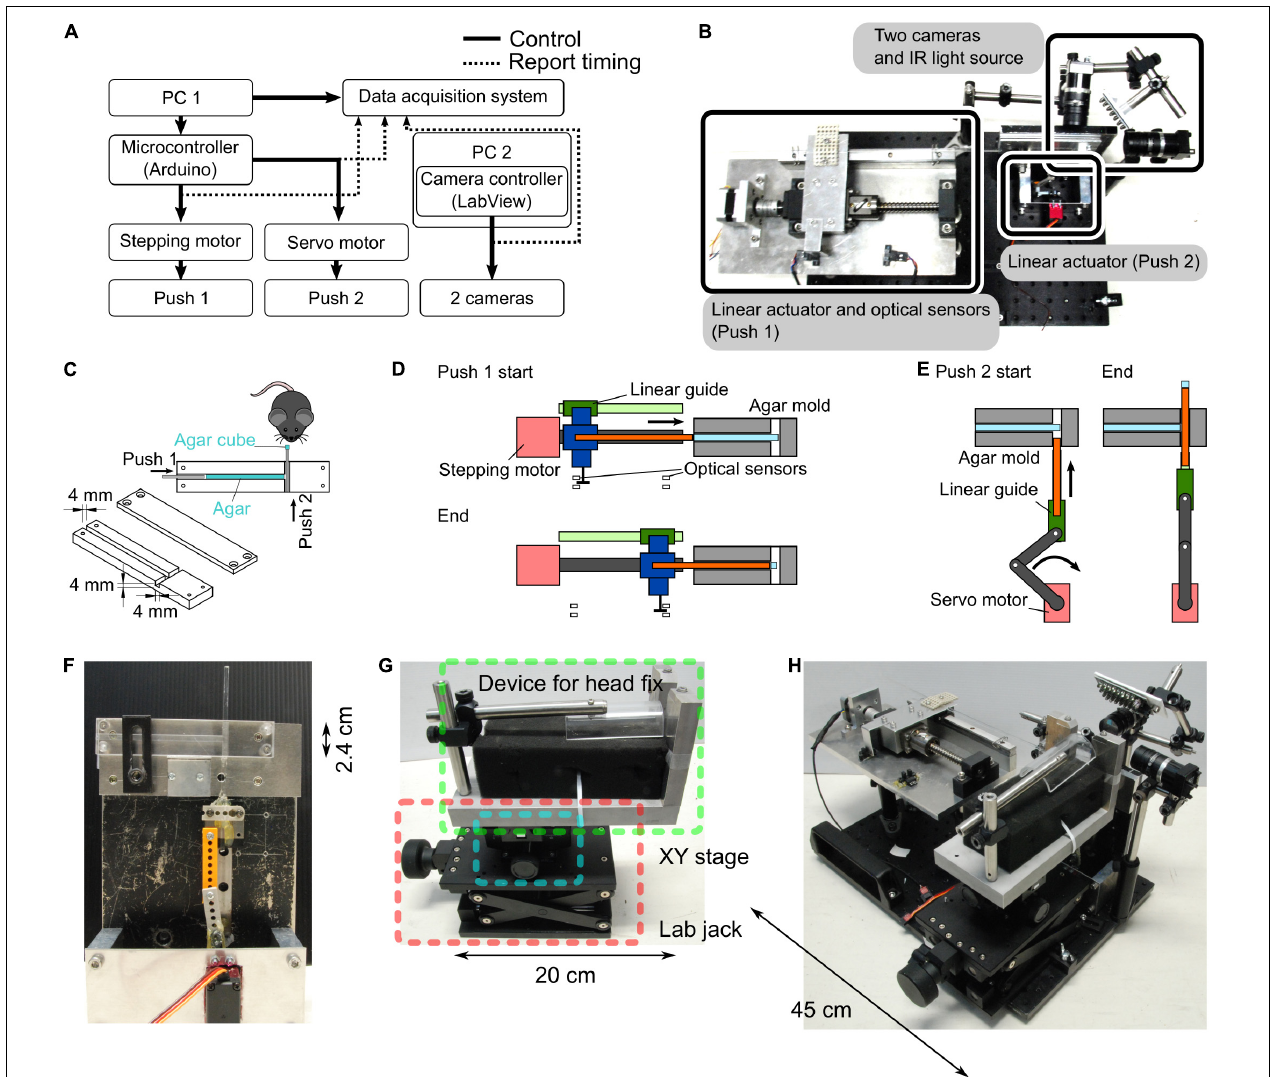
FIGURE 1 | Agar dispenser. (A) Configuration of the agar dispenser system. A microcontroller connected to the PC1 regulates the stepping and servo motors, forming two linear actuators. The orthogonal linear actuators push agar in the agar mold twice (Push 1 and 2), which creates an agar cube. We used another PC (PC2) to observe and record mouse behavior with two cameras. Push timings and camera triggers are stored on the PC1 by a data acquisition board. (B) Photograph showing the top view of the behavior task system. (C) Schematic of the agar mold. Successive pushes by orthogonal plungers (Push 1 → Push 2) create and present the agar cube in front of a mouse. (D) A schematic diagram of the molds before and after extrusion of all the agars is shown. Approximately 20 agar cubes are produced from the start to the end of this process. The position of optical sensors determined the start and end positions of the agar extrusion. The main parts are indicated by the following colors; stepping motor: red, linear guide: green, ball screw: dark gray, push 1 plunger: orange, and connecter between linear guide, ball screw, and push 1 plunger: blue. (E) Schematic of the push 2. For each agar cube (one trial), the agar extruded by push 1 plunger converted into a cube by push 2. The main parts are color-coded as follows; stepping motor: red, linkage: dark gray, linear guide: green, and push 2 plunger: orange. (F) Photograph of a side view of the agar mold and the push 2 mechanism. (G) Apparatus for fixing the head of mice. A manual XY stage (blue square) and a laboratory jack (red square) were placed at the bottom of the device that fixes the mouse head (green square) so that the position of the mouse can be adjusted. (H) Photograph of the whole system (the agar dispenser system with the head fix